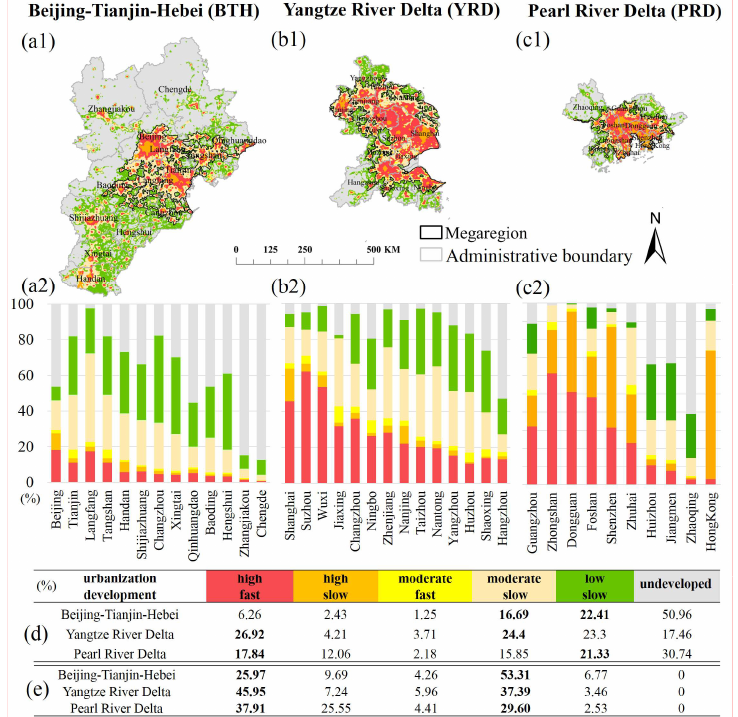
Figure 3. Geographical distribution of five classes of urbanization ( magnitude, development )-diagram of urbanization on pixel scale (upper row : a1– c1 ): ( 1 ) red ( high urbanization, fast development ), ( 2 ) orange ( high urbanization, slow development ), ( 3 ) yellow ( moderate urbanization, fast development ), ( 4 ) beige ( moderate urbanization, slow development ), and ( 5 ) green ( low urbanization, slow development ). Related city scale statistics (defined by administrative boundary) are shown in the middle row ( a2 – c2 ). Statistics comparison within two administrative boundaries ( d ) and megaregions ( e ) are shown in bottom in